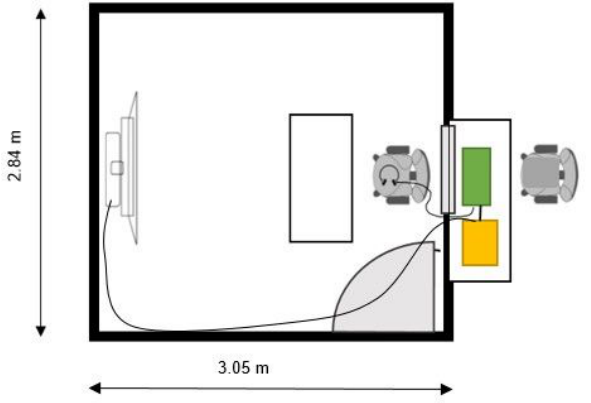
Figure 3: Listening